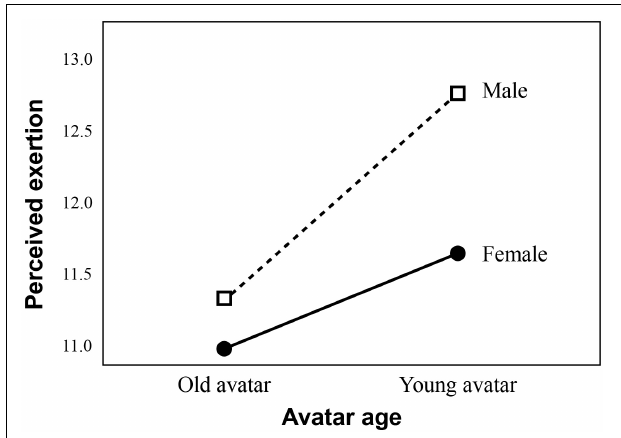
FIGURE 5 | The main effect of avatar age on perceived exertion during the exercise phase (controlling for age and emotion).